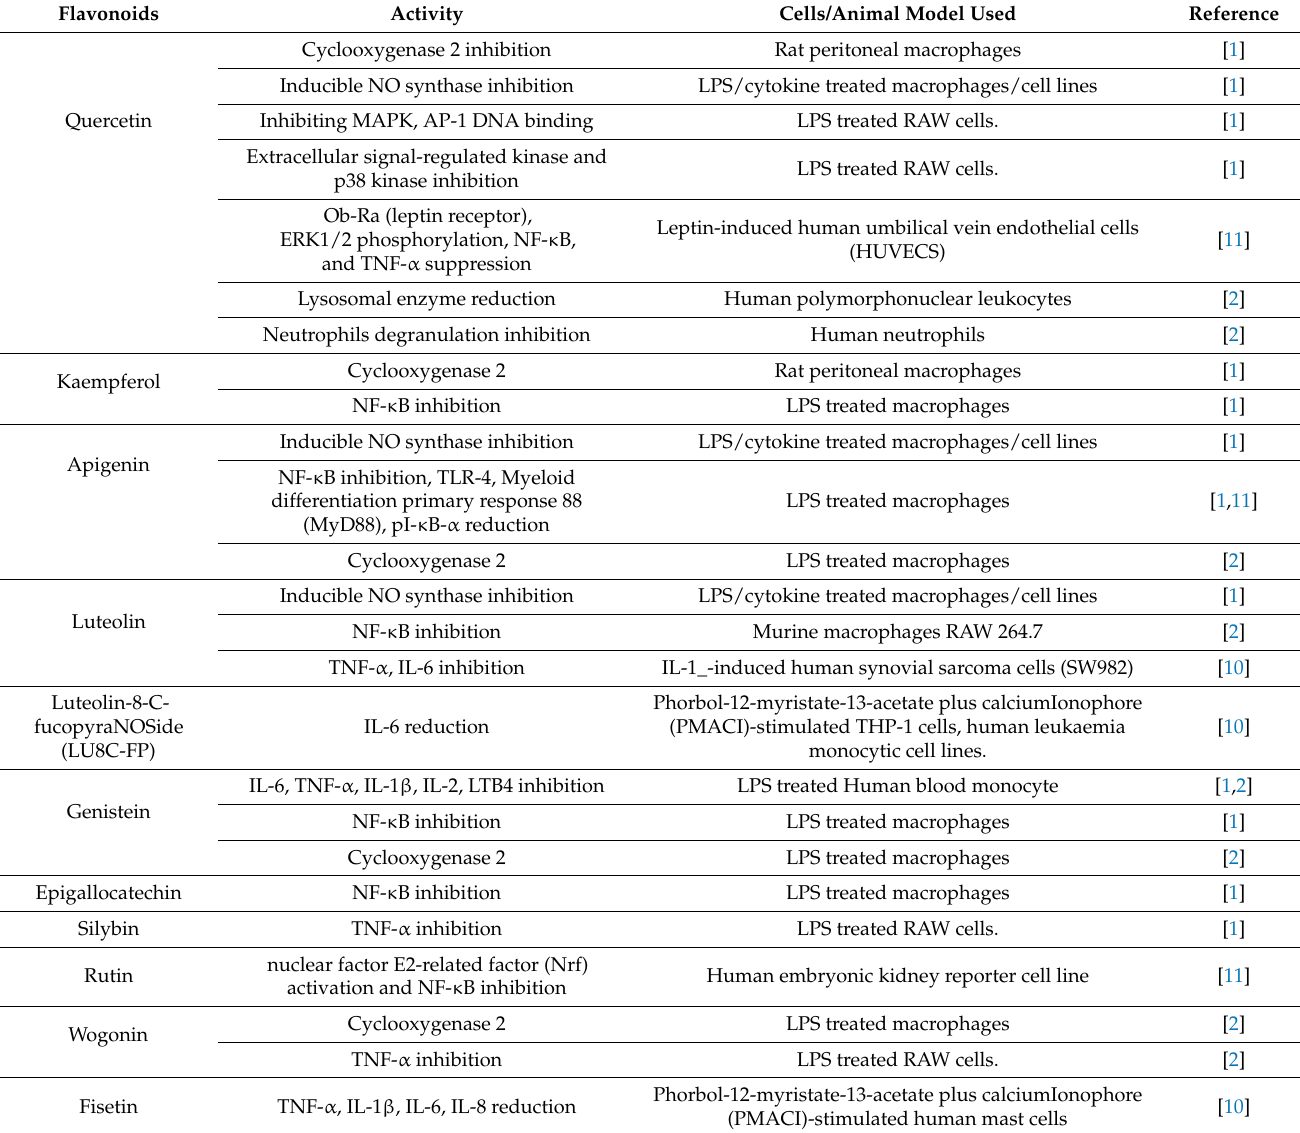
Table 3. Mode of action of few